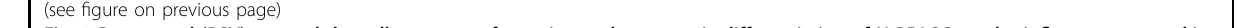
Fig. 2 Resveratrol (RSV) rescued the cell aggregate formation and osteogenic differentiation of N-PDLSCs under in fl ammatory cytokine tumor necrosis factor alpha (TNF- α ) treatment. a – c Histological analysis of PDLSC aggregates ( a ) showed that N-PDLSCs under TNF- α treatment formed thinner aggregates ( b ) with less collagen deposition ( c ), which could be rescued by RSV application. Bars: 50 μ m. d Osteogenesis of PDLSC aggregates demonstrated by ALP (top) and alizarin red staining (bottom). Bars: 5 mm (top) and 50 μ m (bottom). e , f RSV treatment restored the ALP activity ( e ) and mineralizing activity ( f ) of N-PDLSC aggregates under TNF- α application. g Quantitative real-time polymerase chain reaction (qRT-PCR) analysis of the osteogenic marker genes Alp , Runt-related transcription factor 2 ( Runx2 ), Osteocalcin ( Ocn ), and Collagen I ( Col1 ) in PDLSC aggregates after osteogenic induction. The data showed that RSV rescued the osteogenic potential of N-PDLSC aggregates under TNF- α treatment. h Western blot analysis of the extracellular matrix (ECM) and osteogenic marker genes Col1, Periostin, and Runx2 in PDLSC aggregates. i Western blot analysis of molecular targets related to key signaling pathways in PDLSC aggregates: the Sirtuin 1 (Sirt1)-peroxisome proliferator-activated receptor gamma coactivator-1 alpha (Pgc1 α ) pathway; the nuclear factor kappaB (NF κ B) pathway; and the adenosine monophosphate-activated protein kinase (AMPK) pathway. j Western blot analysis showed that RSV improved osteogenesis and ECM deposition in N-PDLSC aggregates under TNF- α treatment, possibly by inhibiting the NF κ B pathway and stimulating the Pgc1 α and AMPK pathways. TNF- α was applied at 10 ng/ml, and RSV was applied at 10 nM in all the experiments. n = 6 per group ( a – f ) and n = 3 per group ( g – j ). The data represent the mean ± SD. * P <